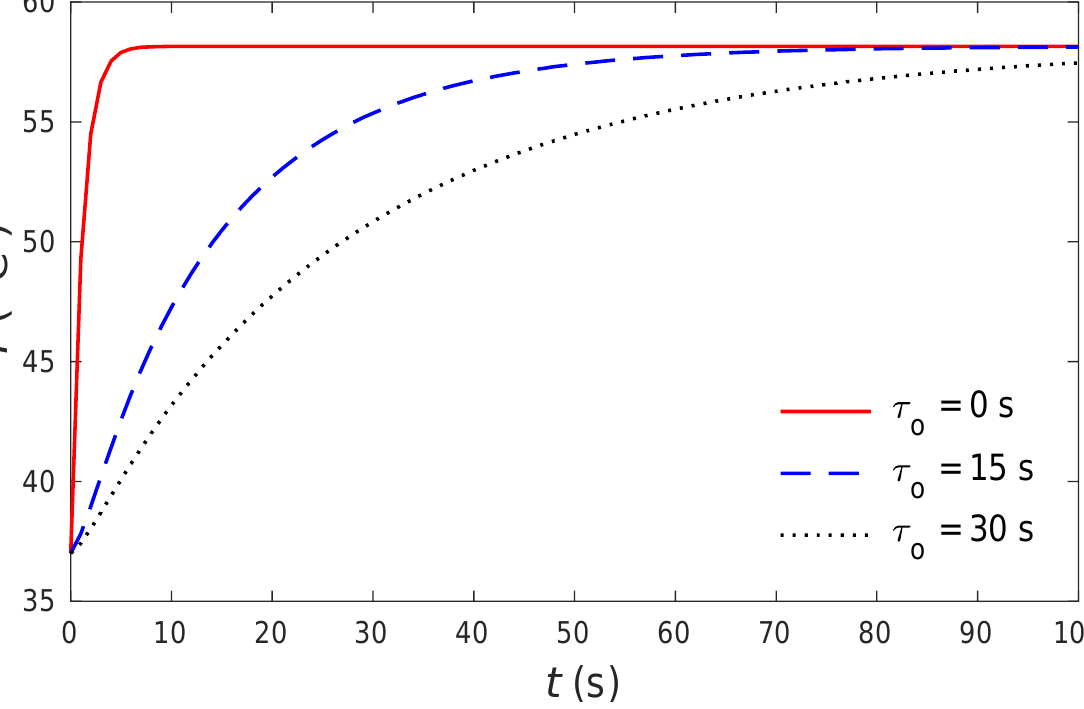
Figure 4. The skin surface temperature over time for several values of 𝜏 𝑜 .